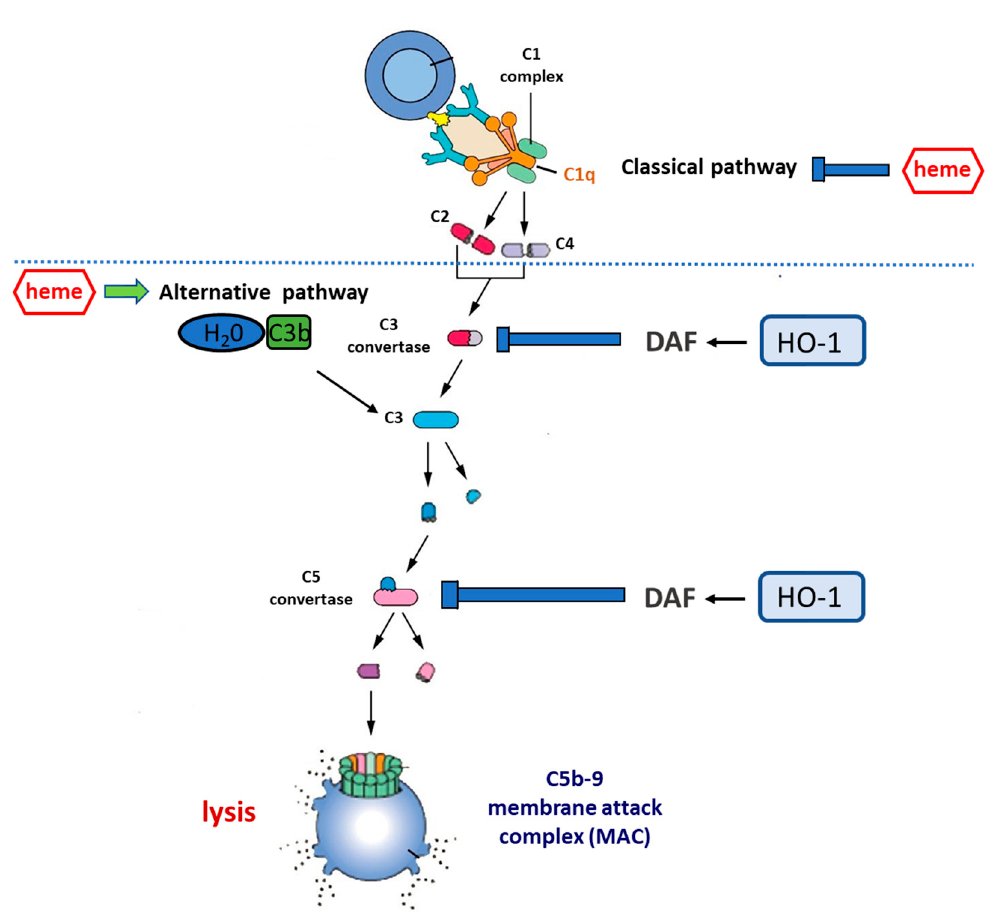
Figure 3. Complement cascade regulation by the heme–HO-1 axis. Central to the activation of complement is the cleavage of circulating C3 to form C3a and C3b. This occurs spontaneously at a low rate in circulation but can be accelerated by: (i) the classical pathway, in which antibodies bound to antigen recruit the C1 complex which, via the activation of circulating C4 and C2, increases the rate of C3 cleavage at the antibody-coated surface; (ii) the alternative pathway (AP), in which C3b binds to circulating factor Bb to form the C3bBb complex that is stabilized by the presence of a biological surface and provides a mechanism for positive feedback, allowing massive C3 activation. Uncontrolled C3 activation is prevented by cell surface regulators, including decay-accelerating factor (DAF, CD55) and membrane co-factor protein (MCP, CD46). C3b generation promotes the cleavage of circulating C5 to form C5a and C5b. C5b generation activates the terminal pathway, in which C6–C9 are recruited to form the membrane attack complex (C5b-9), a pore-like structure causing the lysis of targeted cells. Heme inhibits the classical complement pathway by directly binding to C1q, thus causing changes to IgG binding. On the other hand, heme promotes the activation of the alternative complement pathway and increases C3 deposits. HO-1 regulates the expression of DAF which acts by inhibiting uncontrolled activation of the complement cascade at both the C3 and the C5 level. Therefore, the induction of HO-1 may act as a complement inhibitor, whereas HO-1 depletion may result in the overactivation or unbalanced activation of the complement cascade.